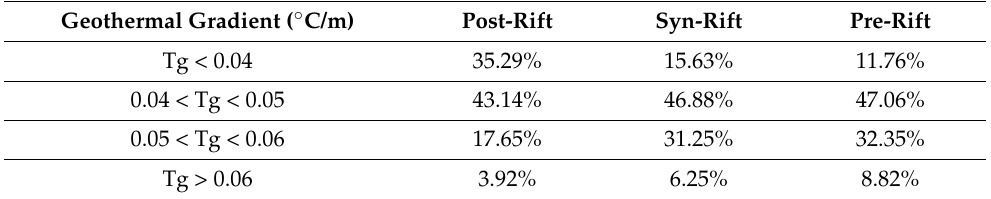
Table 2. Geothermal gradient calculated at the depths of the